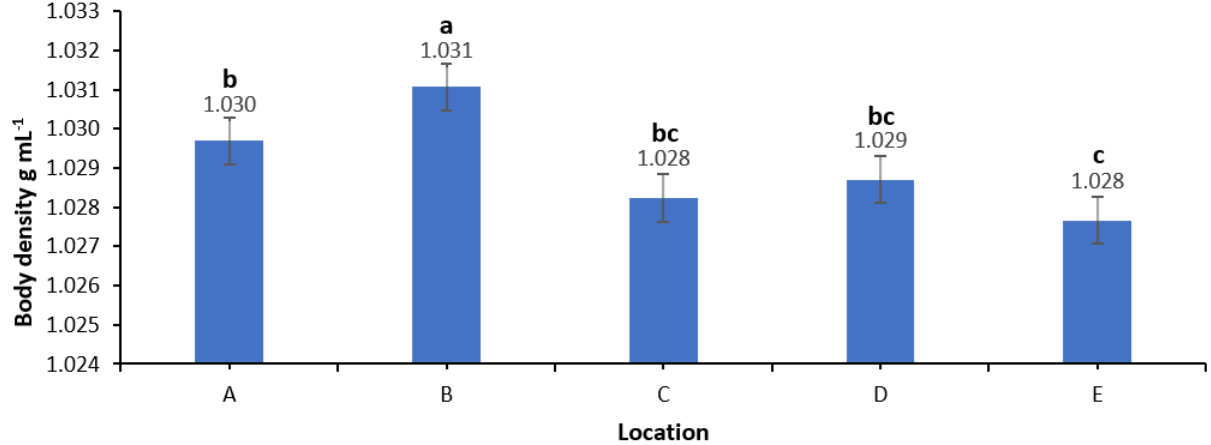
Figure 1. Average densities of lumpfish at each location of the study. Different letters indicate significant difference between sampling locations (Tukey’s post hoc test, p < 0.05). Whiskers indicate ± SD.